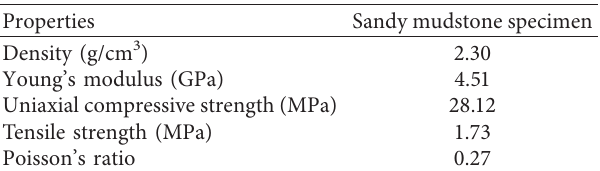
Table 2: Mechanical parameters of the rocks used in the experiments.